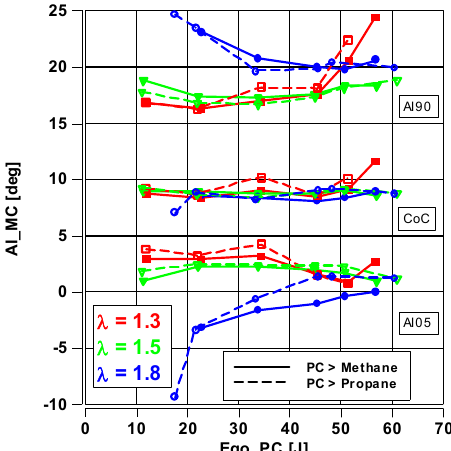
Figure 13. Thermodynamics of the combustion process: beginning of combustion (AI05), center of combustion (CoC), and end of combustion (AI90) determined for average pressure curves during methane and propane combustion.